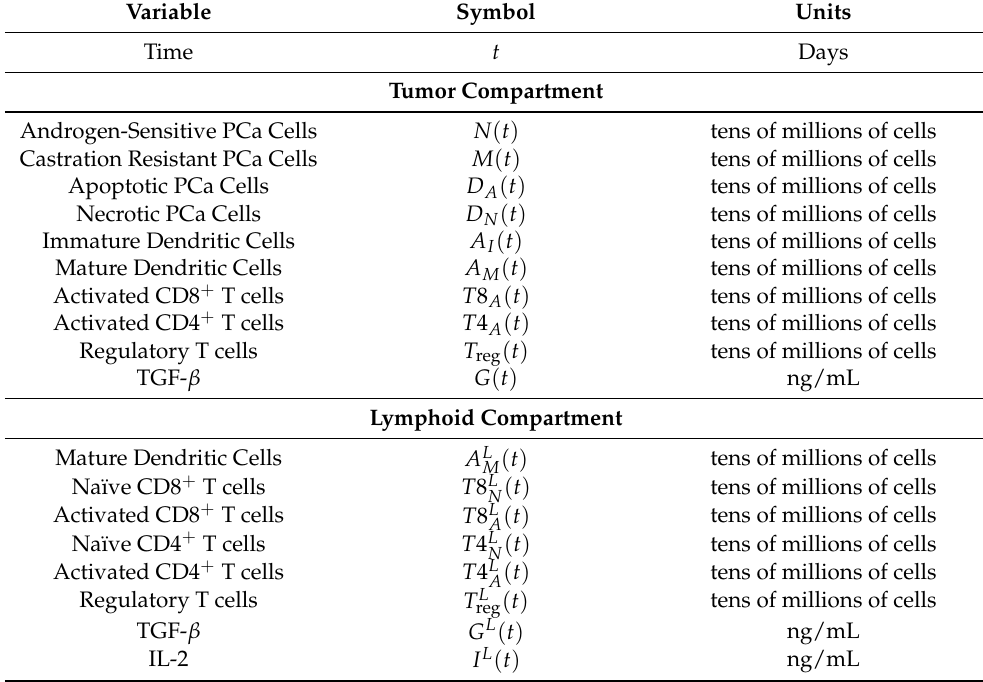
Table 1. Model variables and